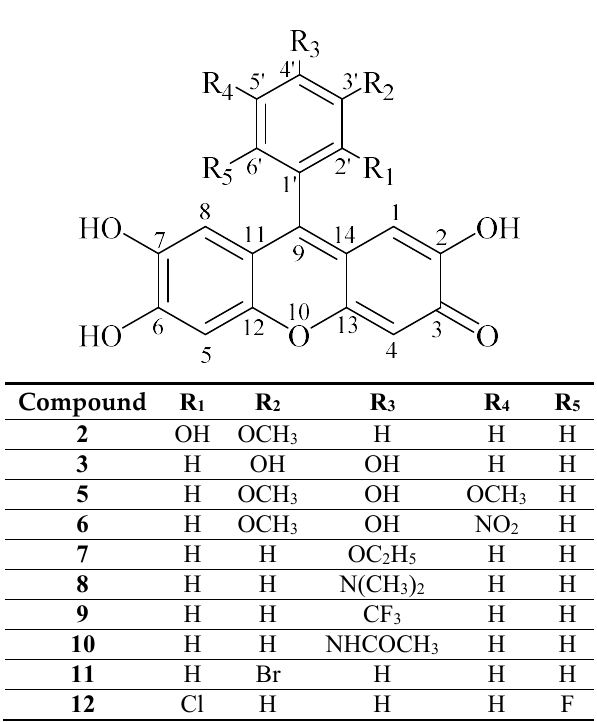
Figure 1. Chemical structures of the tested compounds. Numbering is the same as reported in our previous article [23] .